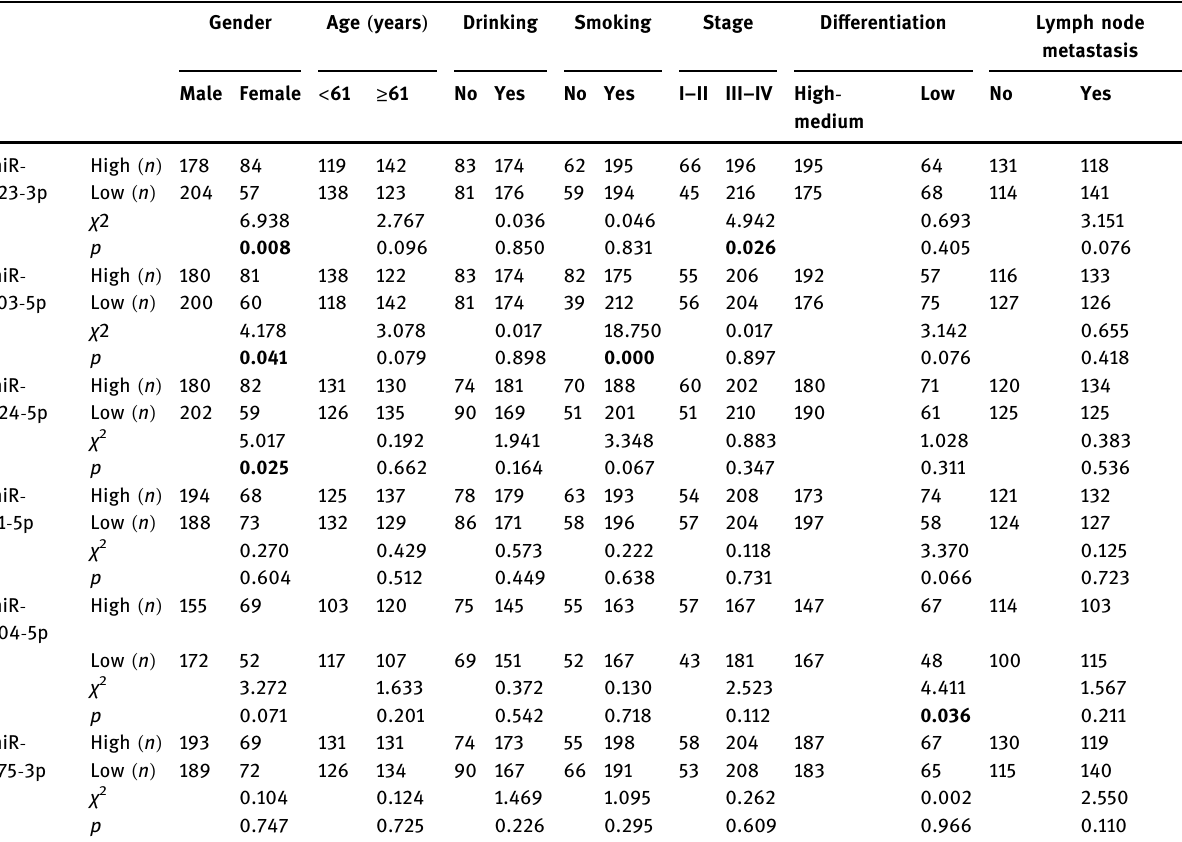
Table 1: Comparison of miRNA expressions in di ff erent clinical